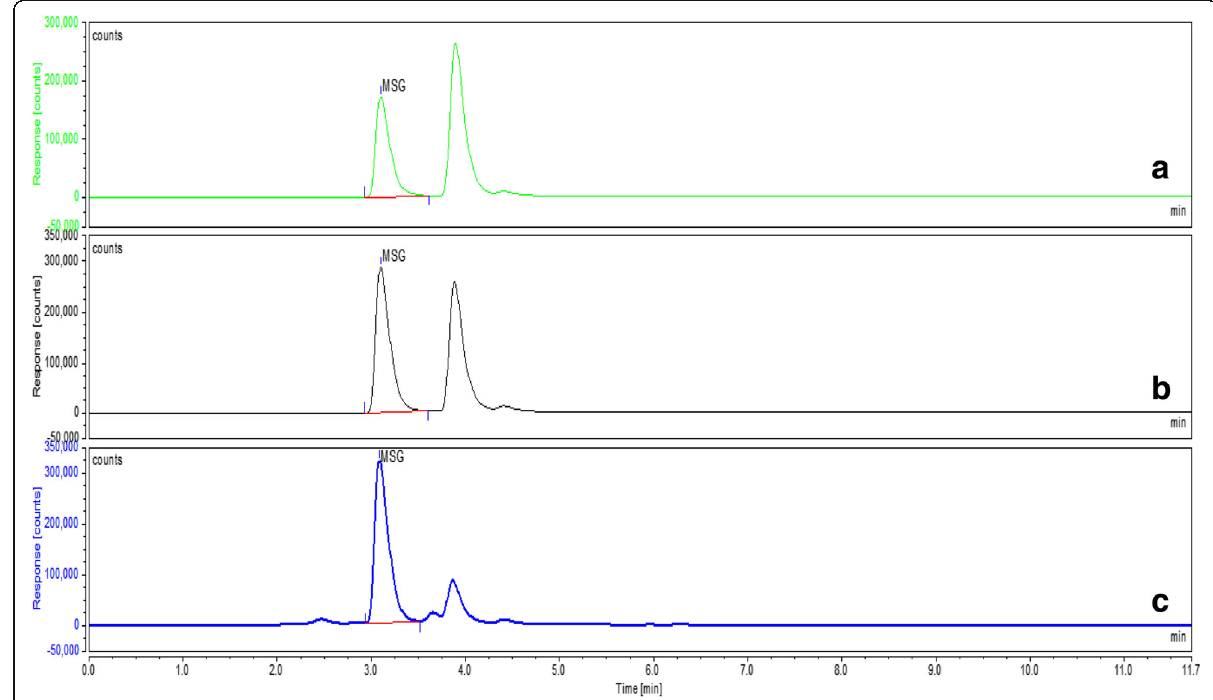
Fig. 5 The concentrations of Sodium glutamate in food samples; Spices ( a ), Indomis ( b ), chipsy ( c